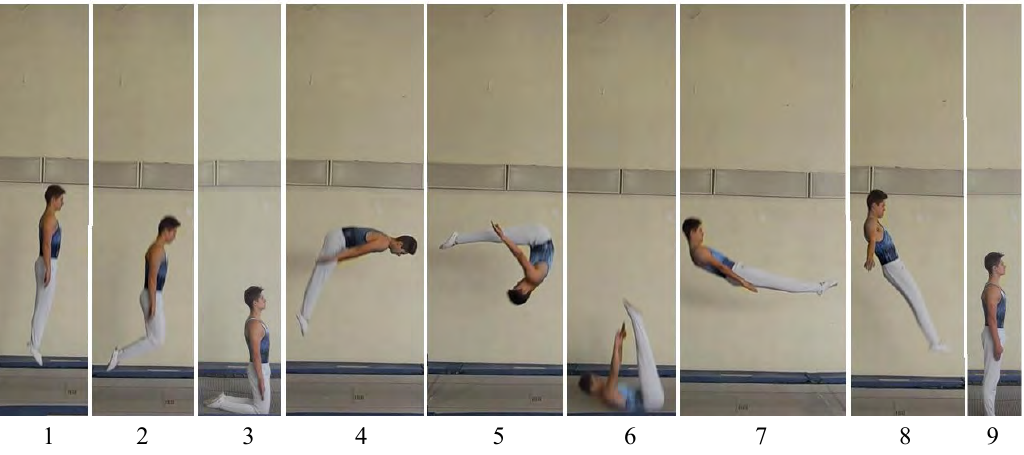
Fig.14 . Combination 2. Temp jumping (shot 1); jump in stance on knees (shots 2 – 3); jump forward with landing in position lying on back, bending, arms are directed forward (shots 4 – 6); coming out of lying on back position and stoppage (shots 7 –